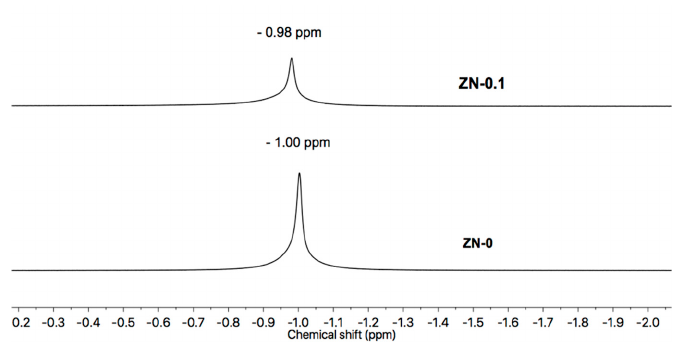
Figure 3. 7 Li NMR spectra of ZN ‐ 0 and ZN ‐ 0.1 electrolytes.